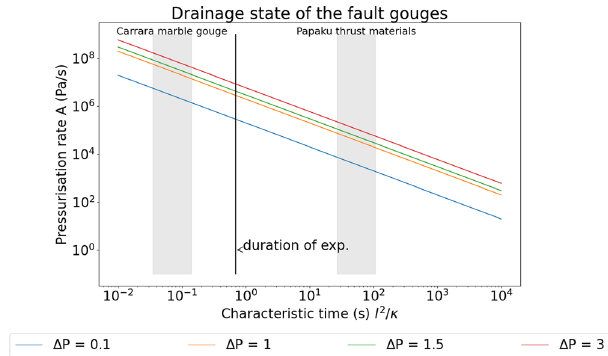
Fig. 3 Characteristic times of diffusion in pressurised fault gouges. In Carrara marble gouge the characteristic time of diffusion (see “ Methods, ” grey shaded area on the left) was lower than the duration of the seismic slip pulse indicating drained deformation. On the other hand, in P ā paku thrust materials (grey shaded area on the right), the characteristic time of diffusion was larger than the duration of the seismic slip pulse, indicating undrained deformation. Under constant pressurisation rate A , the magnitude of the pore fl uid overpressure Δ P decreases with the increase of characteristic times of diffusion: the more permeable Carrara marble gouge is less likely to pressurise than the less permeable P ā paku thrust materials. Pore fl uid overpressures of 0.1 (blue line), 1 (orange line), 1.5 (green line), and 3 (red line) MPa are indicated in the plot 21